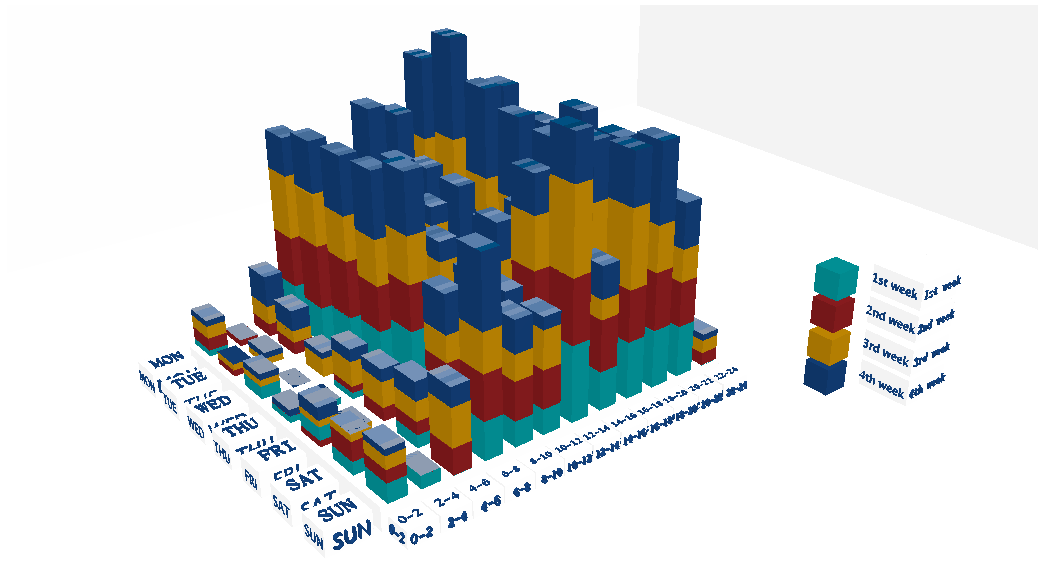
Figure 10 Three-dimensional method